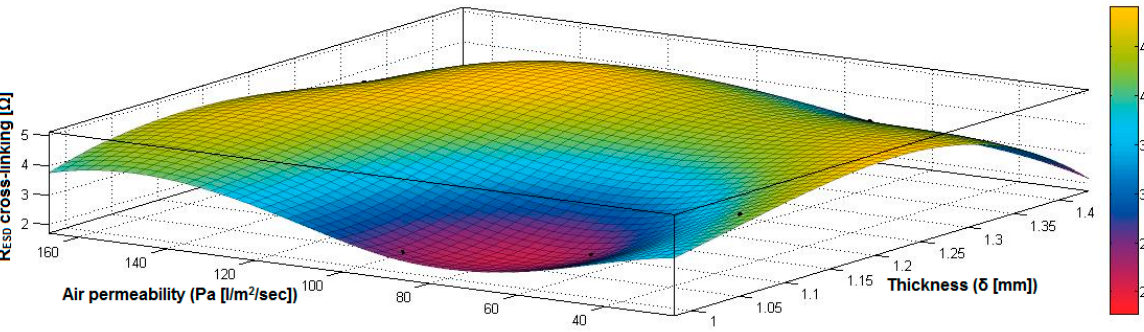
Figure 39. 3D representation R ESD after crosslinking = f(Pa, δ ) samples preliminarily treated in RF plasma O 2 using RF 2 generator and power 50 W.